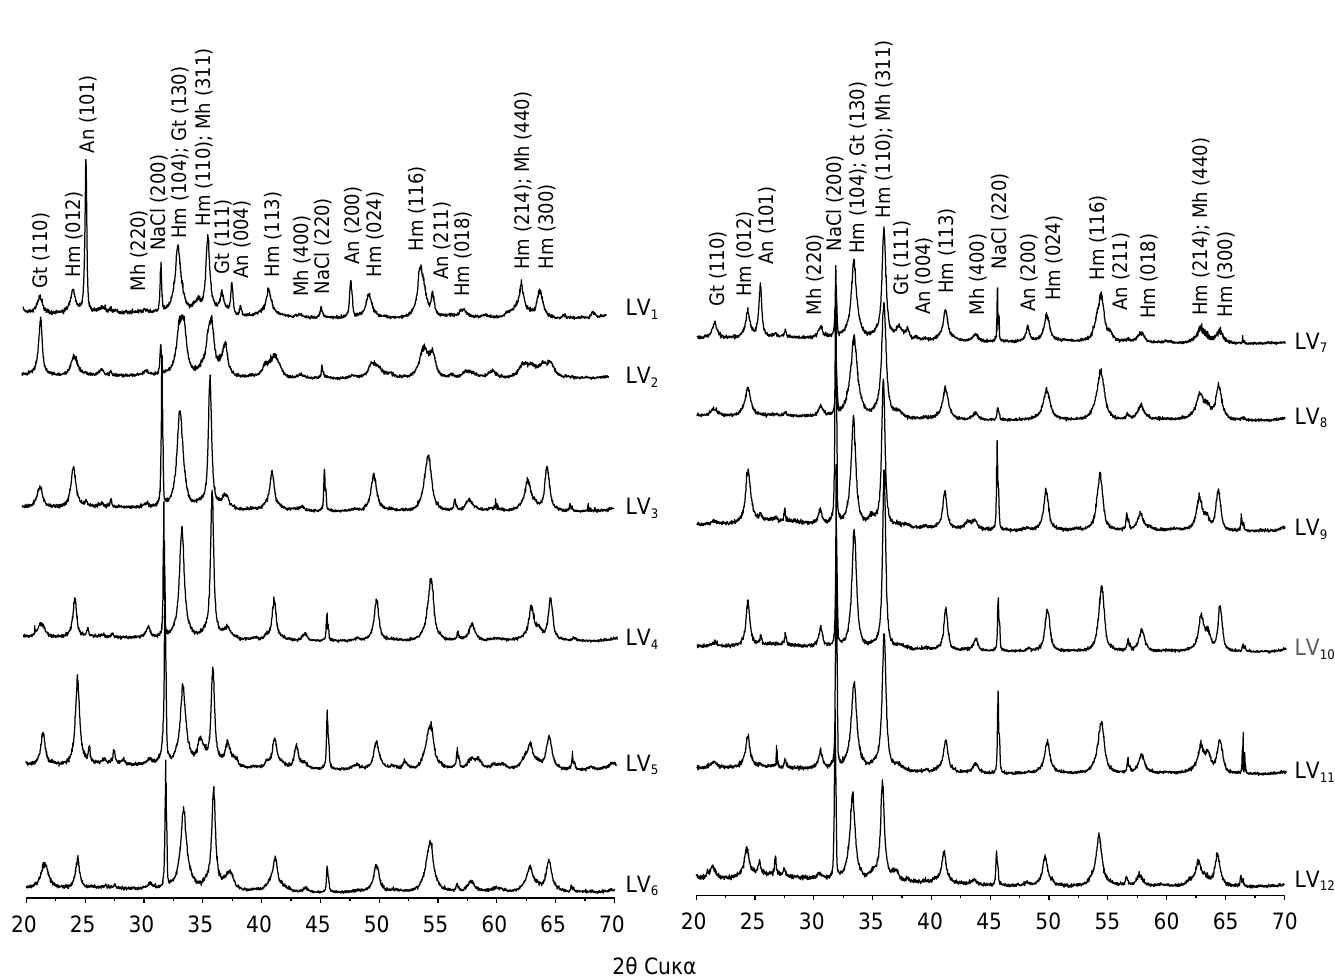
Figure 5. X-ray patterns from clay fraction (powder method) of the soils after alkaline treatment with NaOH 5 mol L -1 . Gt: goethite; Hm: hematite; An: anatase; Mh: maghemite; and NaCl: halite (internal standard used). LV 1 , LV 3 , LV 4 , LV 5 , LV 6 , LV 8 , LV 9 , LV 10 , and LV 11 : Rhodic Hapludox; LV 2 , LV 7 , and LV 12 : Rhodic